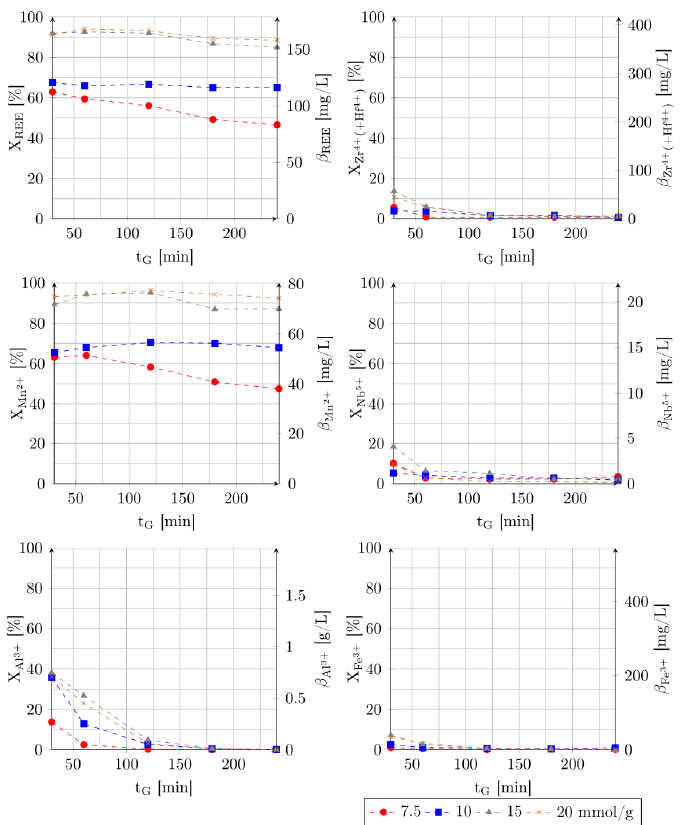
Figure 4. The effect of acid addition and roasting time on leaching yields (primary y-axis) and concentrations (secondary y-axis) of REEs, Zr 4+ (+Hf 4+ ), Mn 2+ , Nb 5+ , Al 3+ , Fe 3+ ( T G = 750 °C; ϱ PD,L = 25 kg/m 3 ; T L = 20 °C; t L = 24 h; r R,L = 300 rpm).